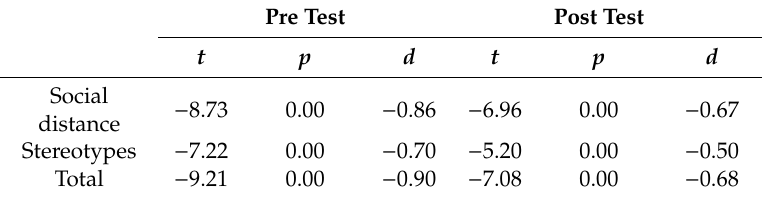
Table 3. Mean di ff erences between the pre-test and post-test of high school and university students. Pre Test Post Test t